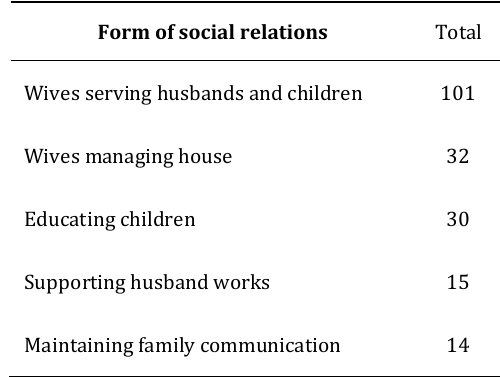
Table 2 Forms of social relations communal sharing between wives and husbands: according to wives with the source from